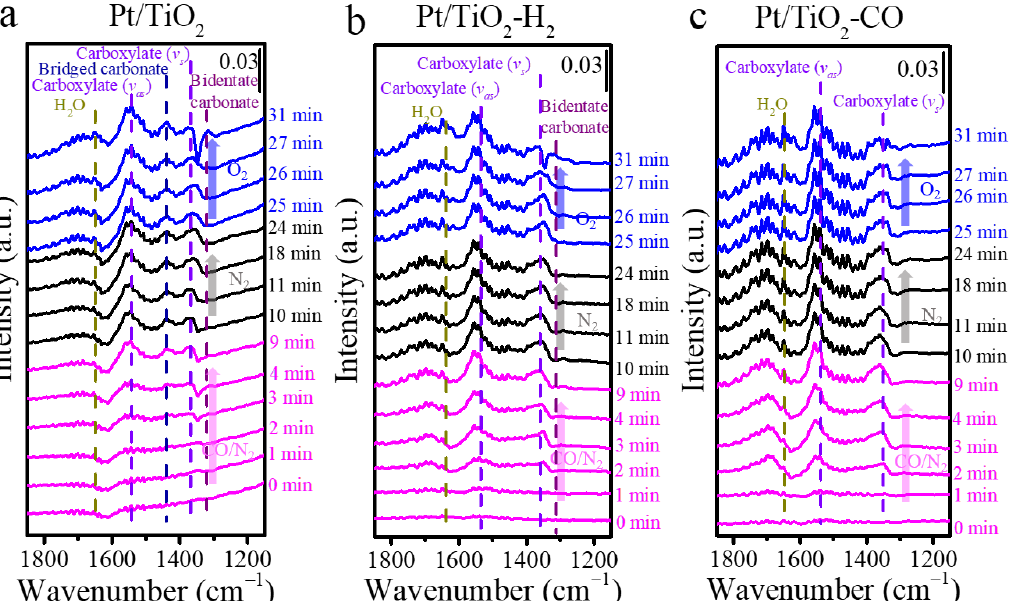
Figure 6. The carbonaceous species presented on in situ DRIFT spectra in the CO adsorption–desorption–oxidation for ( a ) ( a ) Pt/TiO 2 , ( b ) Pt/TiO 2 -H 2 , and ( c ) Pt/TiO 2 -CO catalysts at 200 ◦ C. (Note: In situ DRIFT study was carried in 2 vol.%CO Pt/TiO 2 , ( b ) Pt/TiO 2 -H 2 , and ( c ) Pt/TiO 2 -CO catalysts at 200 °C. (Note: In situ DRIFT study was carried in 2 vol.%CO for 10 min, in N 2 for 15 min, and in O 2 for 6 min.) for 10 min, in N 2 for 15 min, and in O 2 for 6